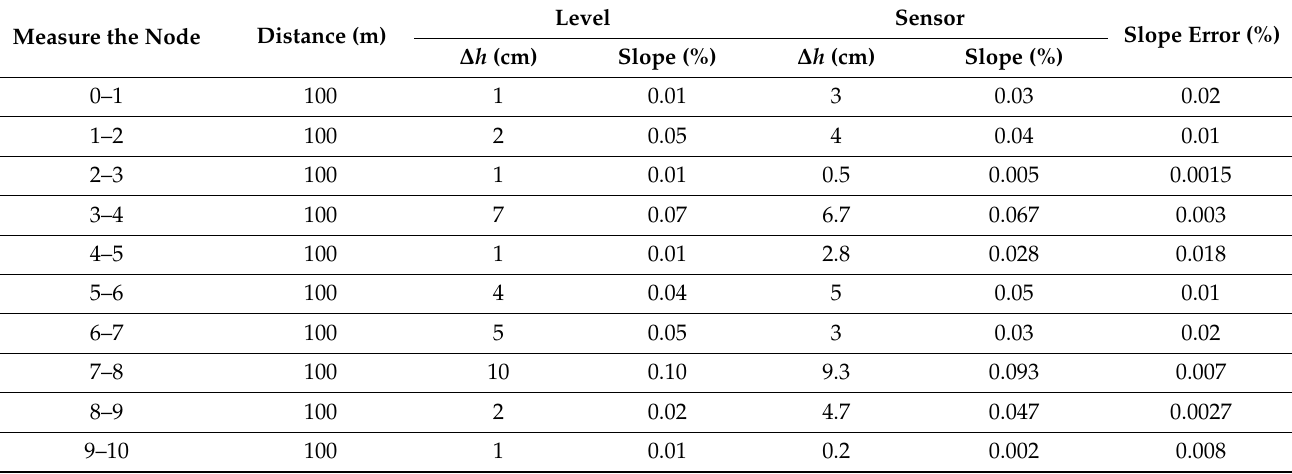
Figure 3. The longitudinal slope of the runway of an aircraft test flight ground. Table 2. The slope of the runway on test flight